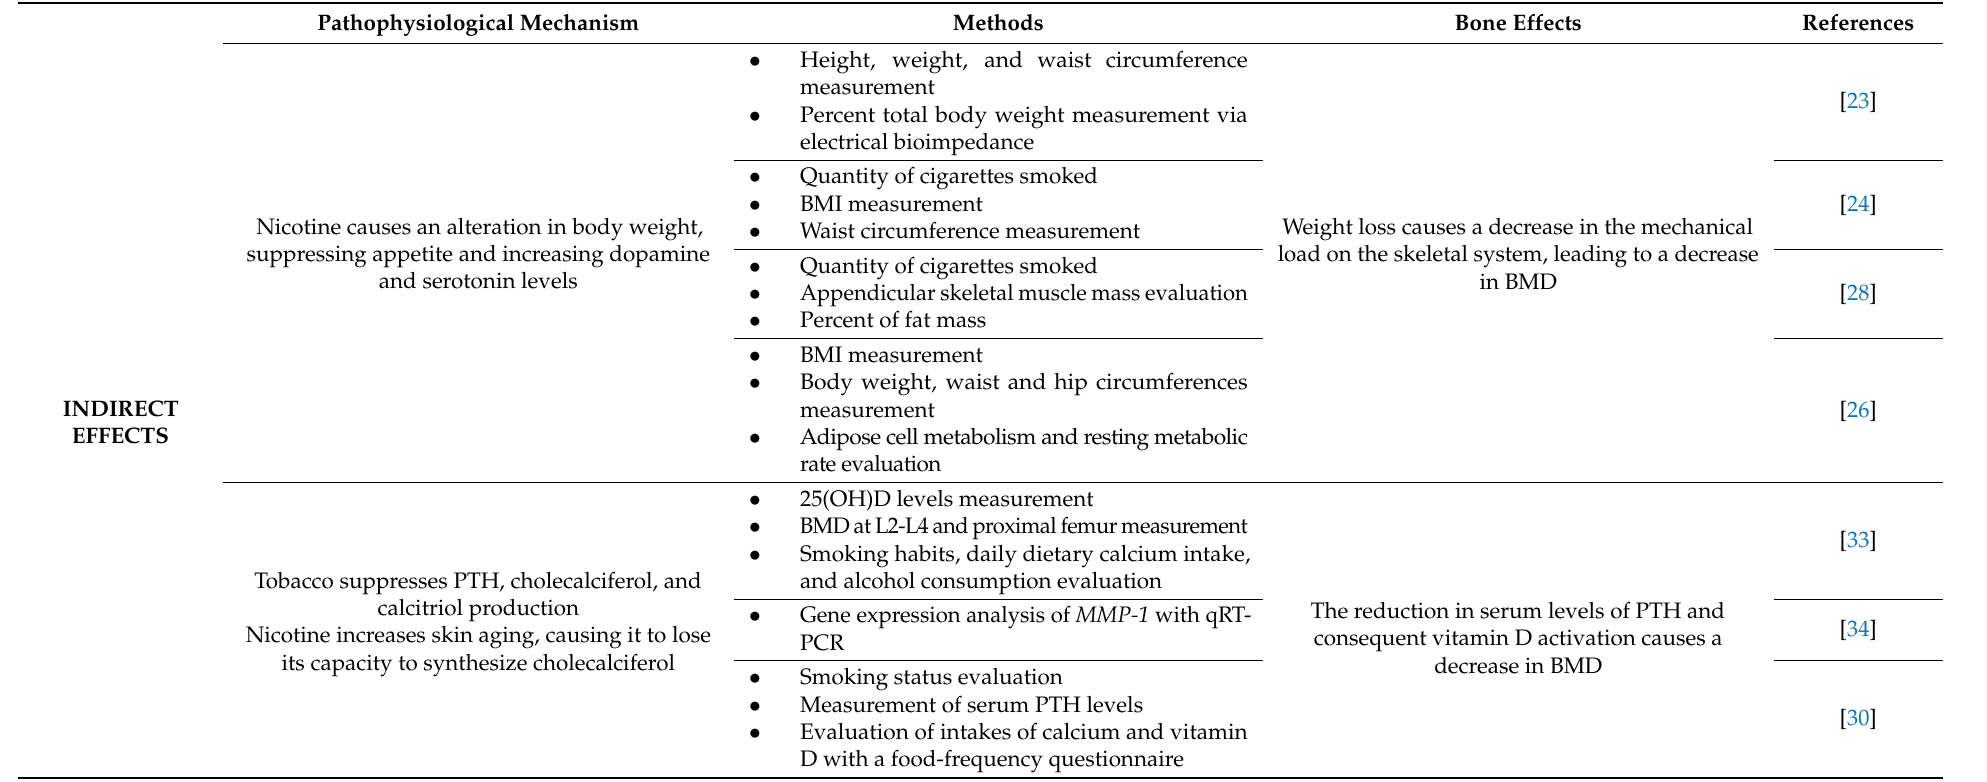
Table 1. Potential pathophysiological mechanisms by which smoking damages bone